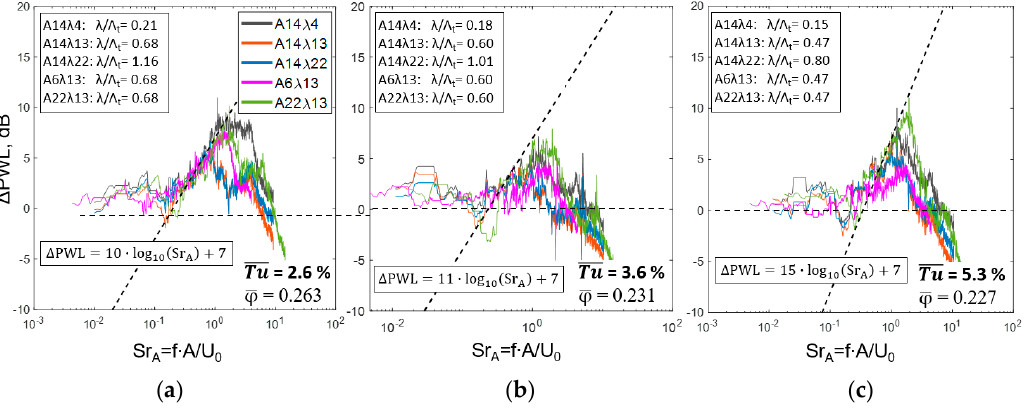
Figure 9. Spectral sound power level reduction Δ PWL of the tested rotors at maximum flow coefficient φ and varying Tu . 20th-order median-filtered signals of broadband components only. Additional indication of the λ / Λ t -ratio. ( a ) 𝑇𝑢(cid:3364)(cid:3364)(cid:3364)(cid:3364) = 2.6%; ( b ) 𝑇𝑢(cid:3364)(cid:3364)(cid:3364)(cid:3364) = 3.6%; ( c ) 𝑇𝑢(cid:3364)(cid:3364)(cid:3364)(cid:3364) = 5.3%.